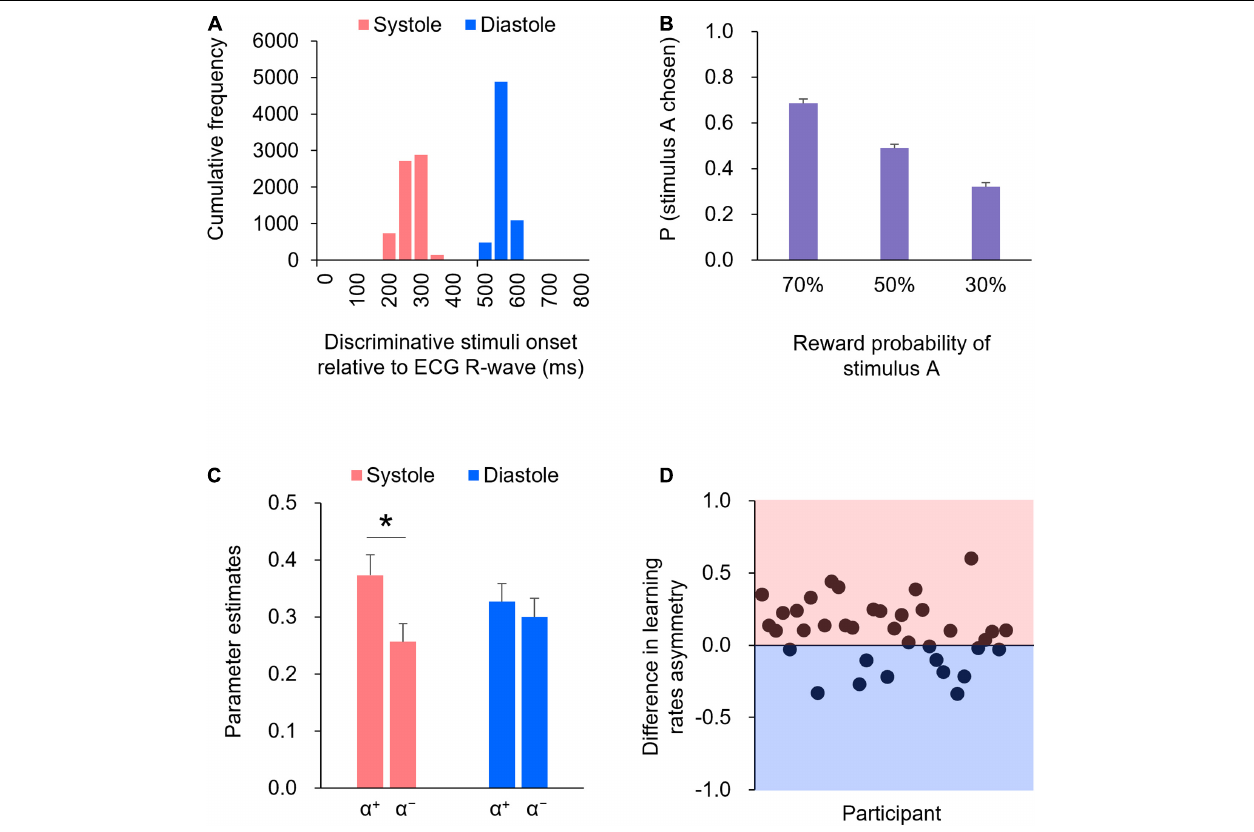
FIGURE 2 | (A) The precision of the timing within the cardiac cycle, relative to the R-wave peak, is shown in the histogram. (B) The proportions of choosing stimulus A for each reward probability block. Error bars indicate standard error (SE). (C) Mean of the learning rates ( α + and α − ) in the systole and diastole trials. Error bars indicate SE. An asterisk indicates a significant difference in the learning rate between the systole and diastole trials ( * : p < 0.05). (D) The difference in the learning rate asymmetry ( α + − α − ) between the systole and diastole trials for each participant. The positive value represents a larger learning rate asymmetry in the systole trials relative to the diastole trials, whereas the negative value represents a larger learning rate asymmetry in the diastole trials relative to the systole trials. In 24 of 36 participants, there were larger learning rate asymmetry in the systole trials compared to the diastole